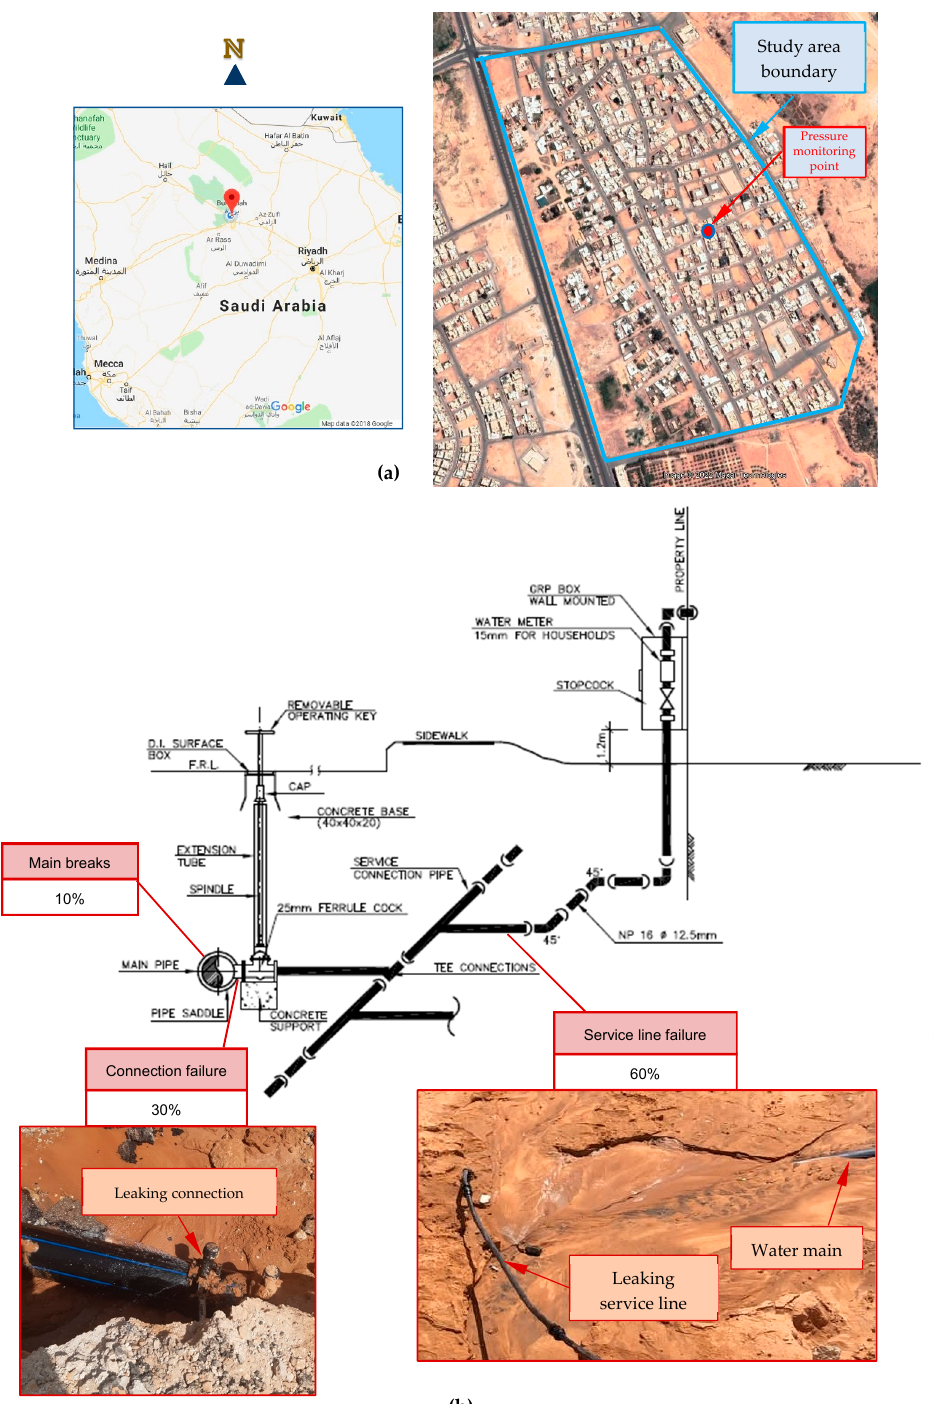
Figure 1. Study area and problem identification, ( a ) location of the study area the in Buraydah City of Qassim Region, ( b ) service connection details showing percentage contribution of each structural failure, 60% leaking service line, and 30% leaking connections.